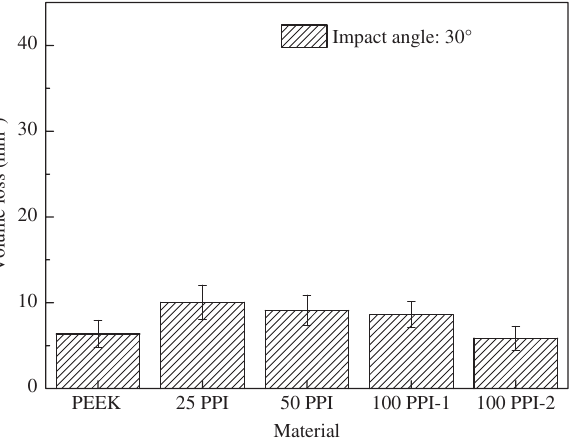
Figure 6: Volume loss results of the different materials with an impact angle of 30 ° .